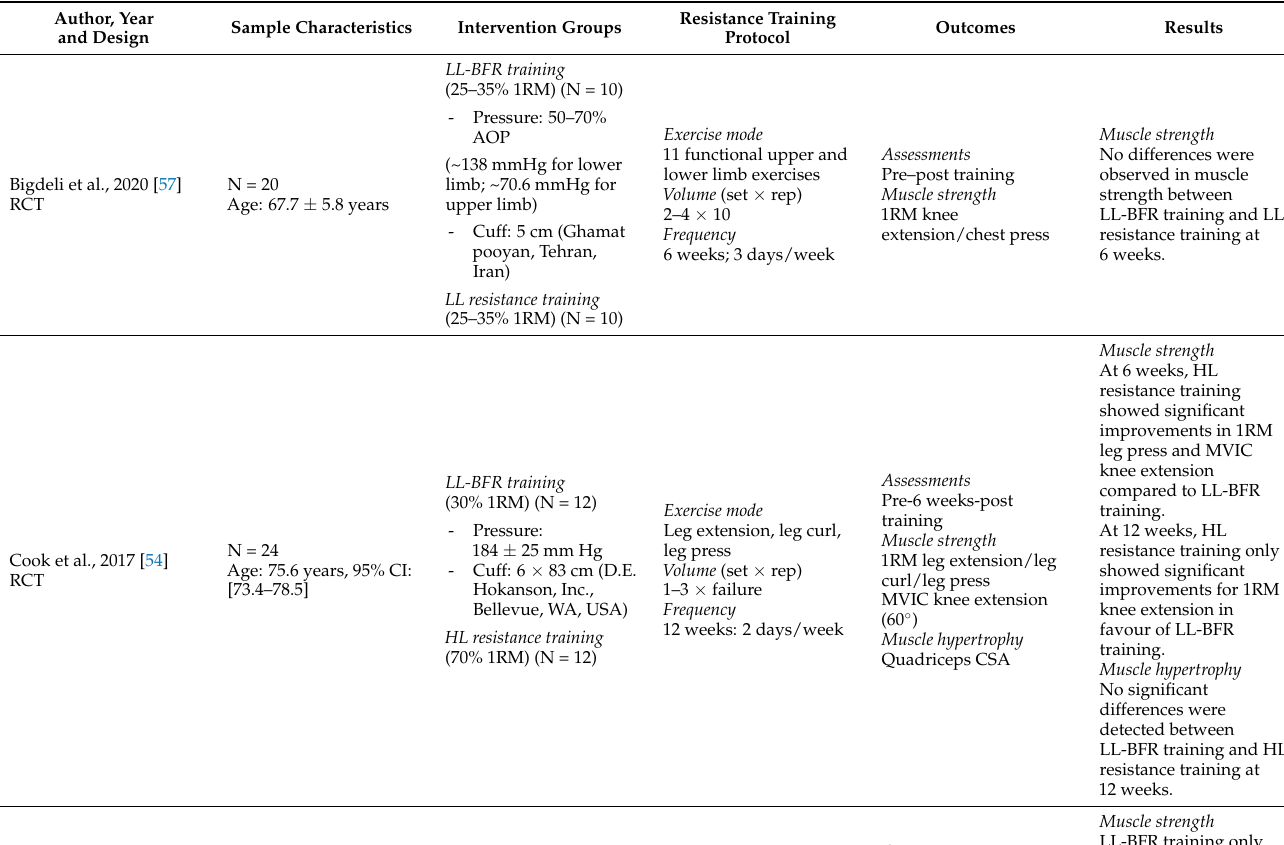
Table 1. Methodological characteristics and results of included